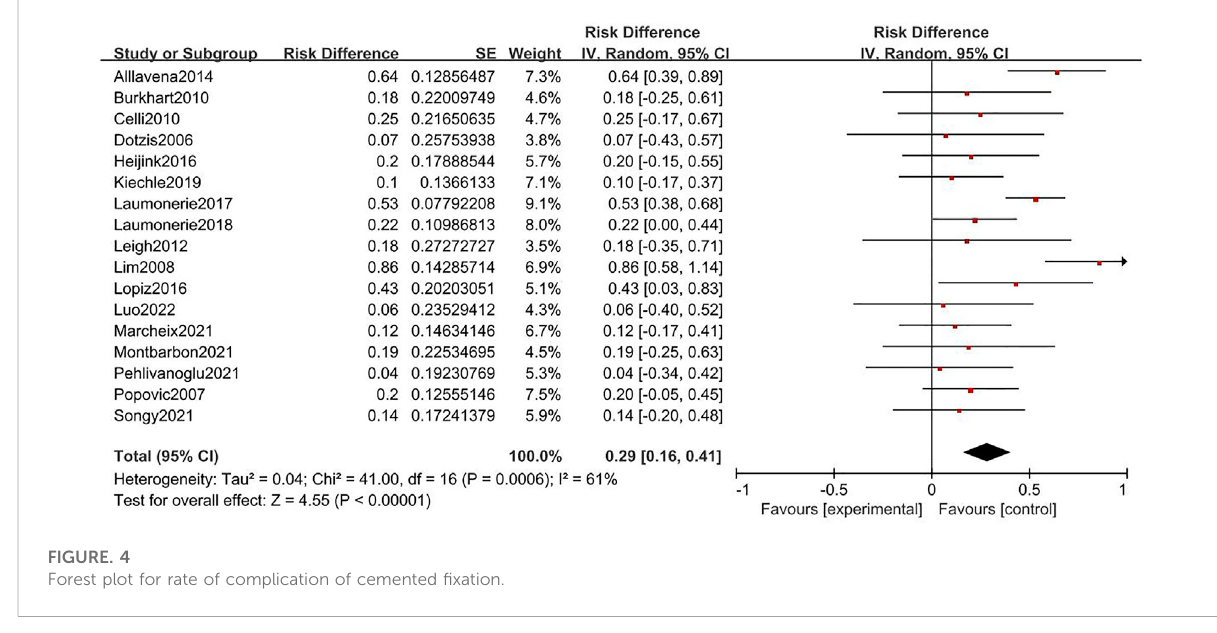
FIGURE. 4 Forest plot for rate of complication of cemented fi xation.